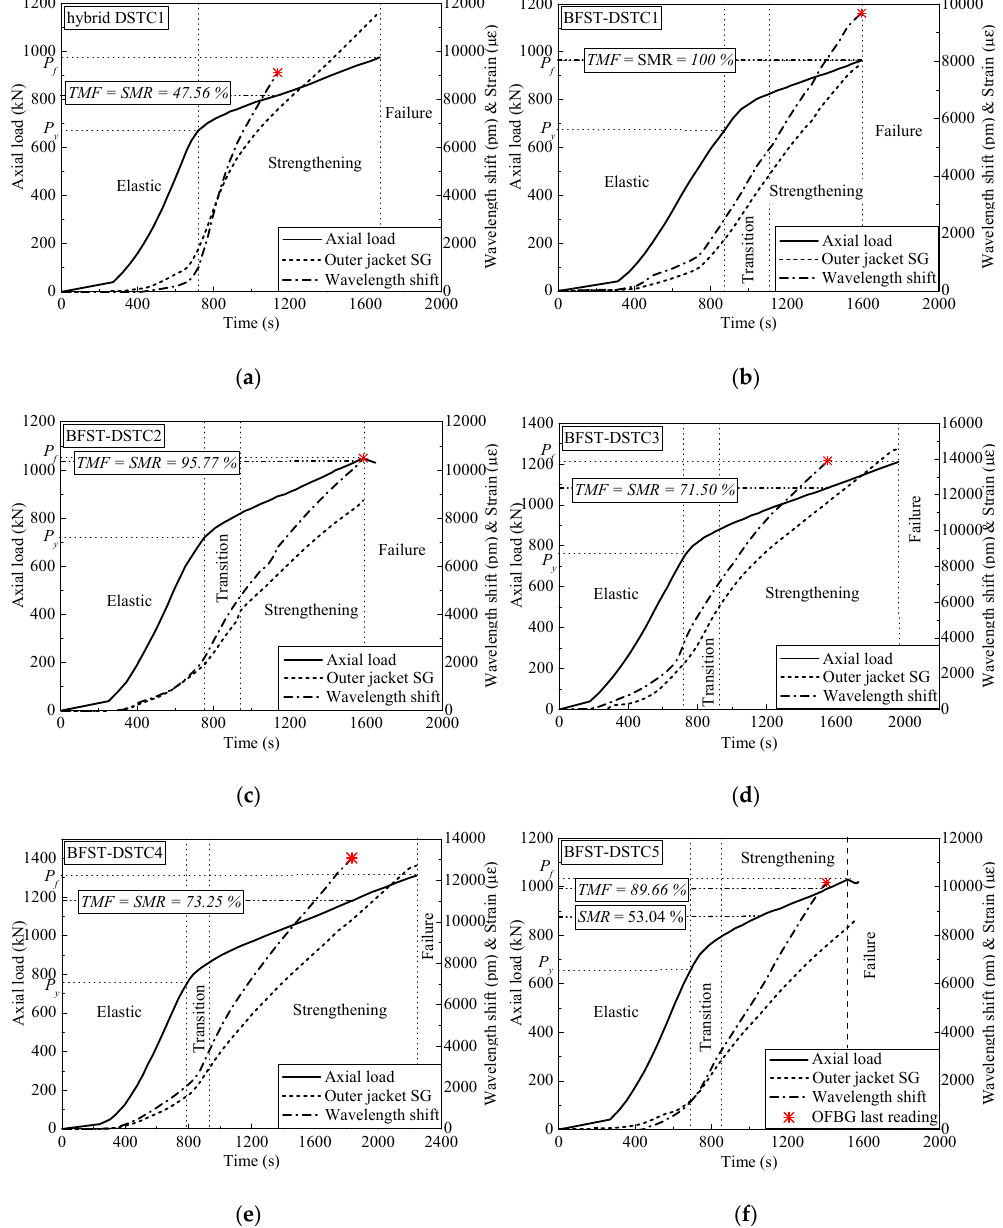
Figure 6. Hoop strain self-sensing performance of the outer tube for specimens with normal strength (concrete) NSC: ( a ) Hybrid DSTC1; ( b ) BFST-DSTC1; ( c ) BFST-DSTC2; ( d ) BFST-DSTC3; ( e ) BFST-DSTC4; ( f ) BFST-DSTC5. TMF: Total measurement from optical fiber Bragg grating sensors (OFBGs), SMR: Strain measurement range, * OFBGs’ last